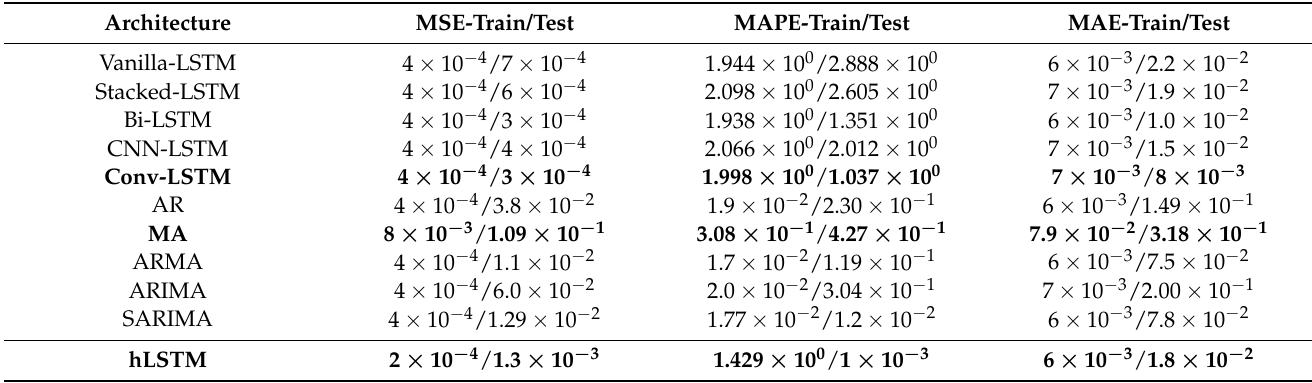
Table 4. Results of evaluation metrics for memory used with one virtual machine.